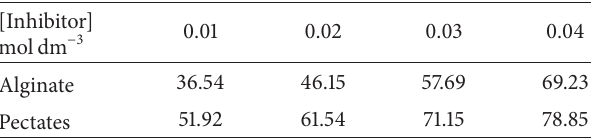
Table 2: Percentage of inhibitor efficiency (% I.E.) for corrosion of Al in alkaline media in presence of inhibitors. [ OH − ] = 4.0 and I = 4.0 moldm − 3 at 30 ∘ C.